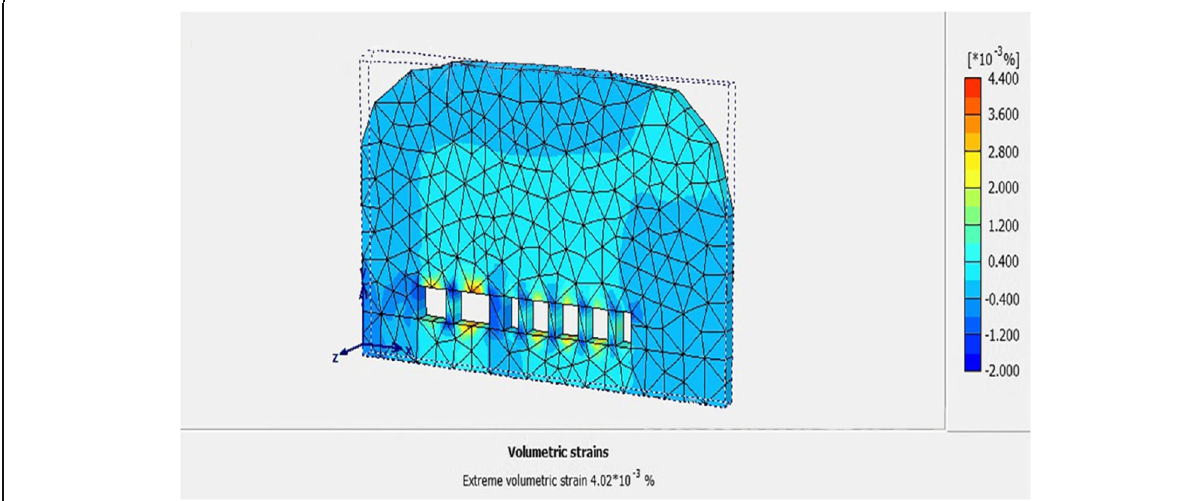
Fig. 24 Volumetric strains of the support rock pillars in Chamber 3. PLAXIS